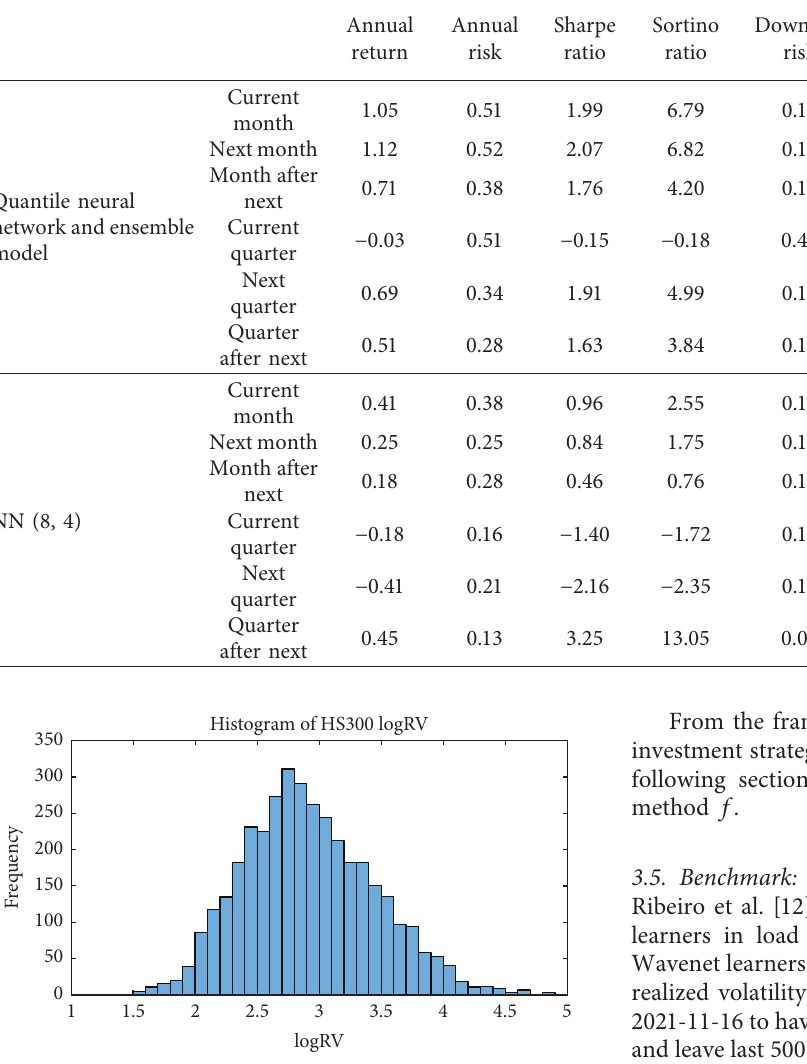
Figure 1: Histogram of logarithmic realized volatility of CSI 300